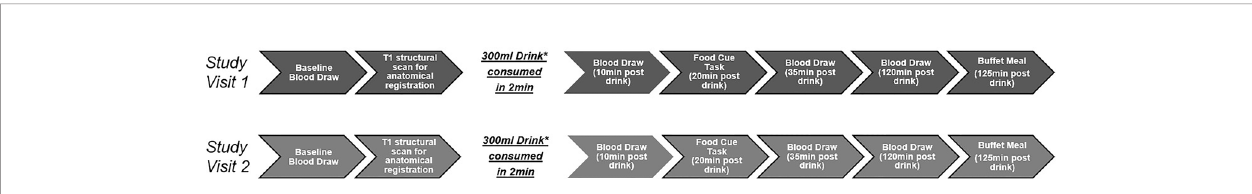
FIGURE 1 | Visualization of the study visits. *300ml noncaloric cherry fl avored drink. Either water or 75g of glucose dissolved in water. Order of drinks were